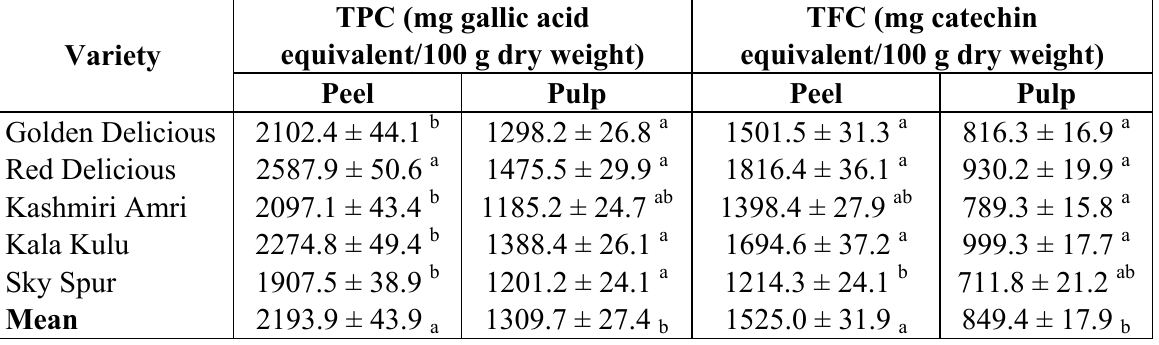
Table 1. Total phenolics and total flavonoids contents of peel and pulp extracts of different cultivars of apple ( Malus domestica Borkh.)